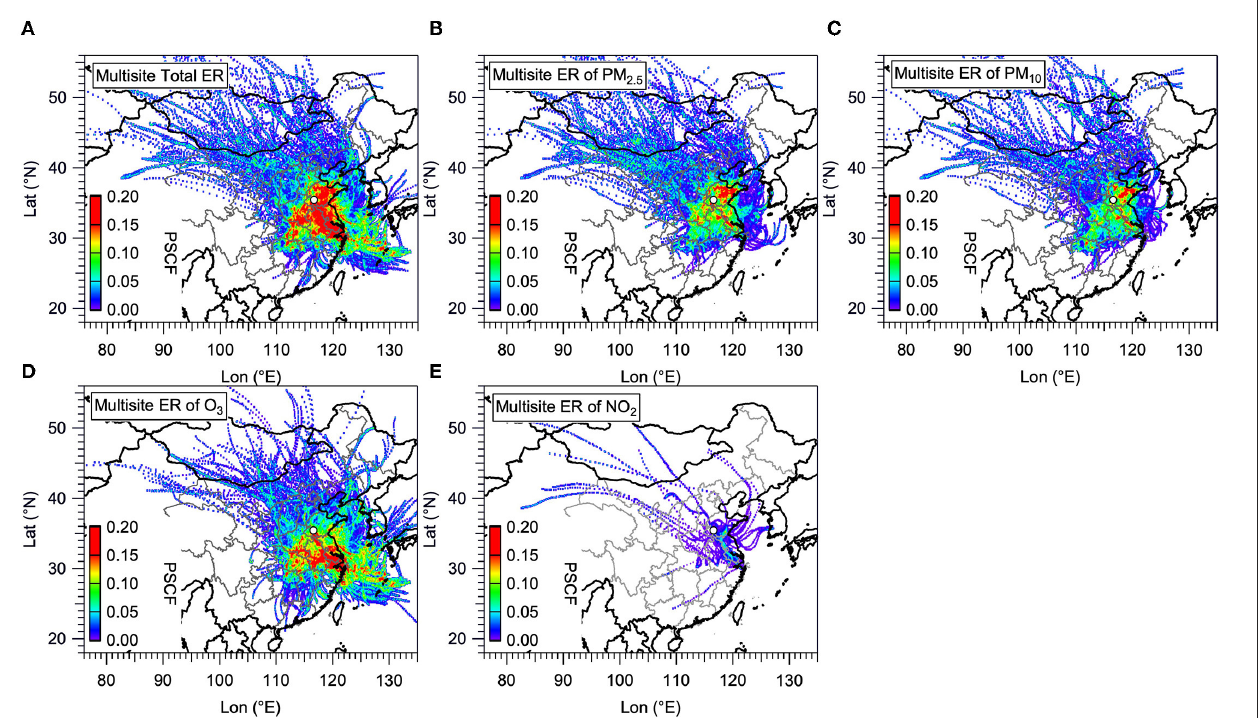
FIGURE6 The potential source areas (PSA) of the excess risks (ERs) of air pollutants (based on CAAQS standards) in the four functional areas in Jining estimated based on multi-site emerging method. The color scale represents the possibility of the ER source, while the areas of hot spots covered can be considered as the PSA for each pollutant ( A : Total; B : PM 2.5 ; C : PM 10 ; D : O 3 ; and E : NO 2